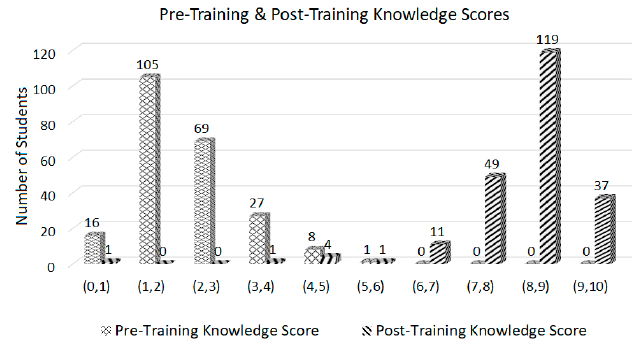
Figure 6. Pre-Training and Post-Training Knowledge Score.